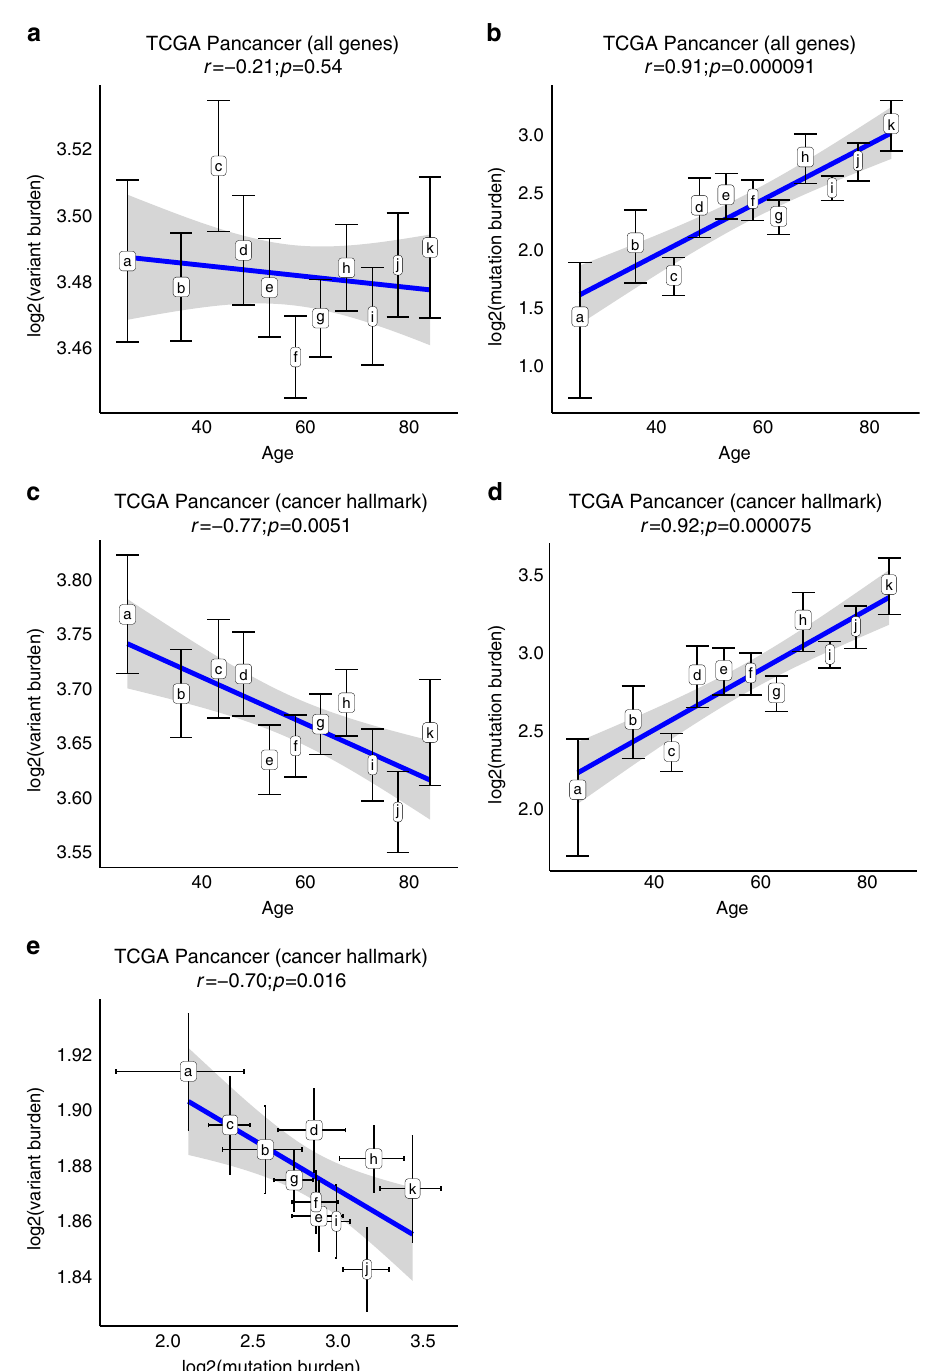
Fig. 2 Correlations between the average gHFI variant burden and somatic mutation burden and age in the TCGA ( n = 7468 cases). a Variant burden in all human genes ( n = 19,581 genes) versus age intervals. b Mutation burden in all human genes versus age intervals. c Variant burden in cancer hallmark genes ( n = 1558 genes) versus age intervals. d Mutation burden in cancer hallmark genes versus by age intervals. e Correlation between variant burden and mutation burden in cancer hallmark genes across age. Tags a – k indicate age intervals corresponding to ages ≤ 30 ( n = 307), 31 – 40 ( n = 545), 41 – 45 ( n = 405), 46 – 50 ( n = 568), 51 – 55 ( n = 820), 56 – 60 ( n = 1014), 61 – 65 ( n = 1080), 66 – 70 ( n = 958), 71 – 75 ( n = 820), 76 – 80 ( n = 572), and ≥ 81 ( n = 379) years. The y -axes correspond to log 2 transformed variant/mutation burden. Error bars represent standard error. The r represents Pearson correlation coef fi cient. Spearman ’ s Rho test (two-sided) was used to generate the p value to measure the strength of correlation coef fi